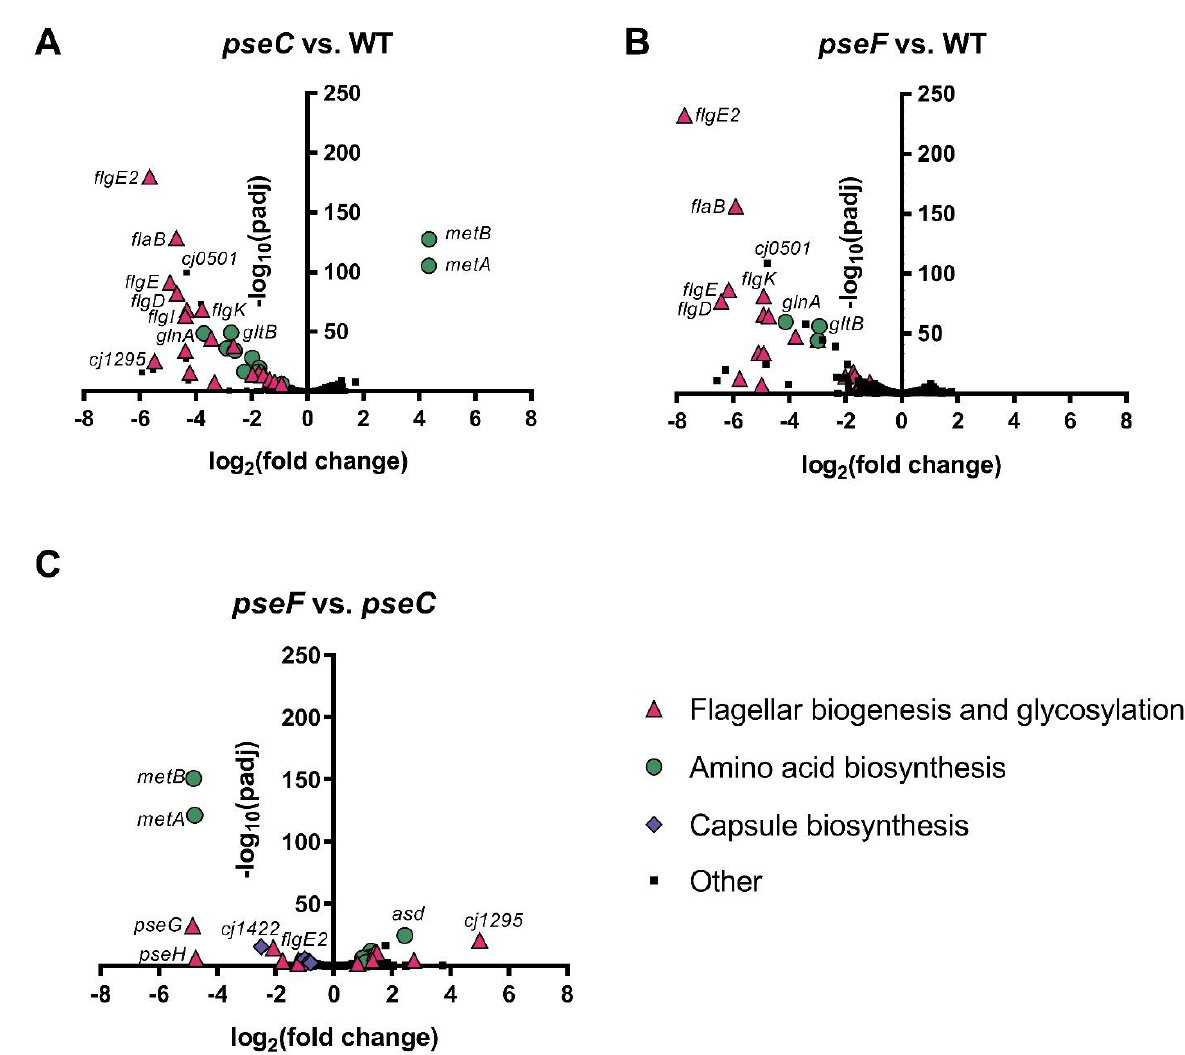
Figure 3. Volcano plots showing the most significantly differentially expressed genes between C. jejuni NCTC 11168 wild type, ∆ pseC and ∆ pseF cells. Significantly differentially expressed genes between ∆ pseC and wild type ( A ), between ∆ pseF and wild type ( B ) and between ∆ pseF and ∆ pseC ( C ) are shown. The negative log of the false discovery rate (FDR)-adjusted p -value vs. the log 2 fold change between the conditions indicated is plotted for each gene. Genes with a fold change +/ − 1.5 and FDR-corrected p -value < 0.05 were considered differentially expressed. Selected significantly differentially expressed genes are represented by different colours and symbols according to their predicted or known function.